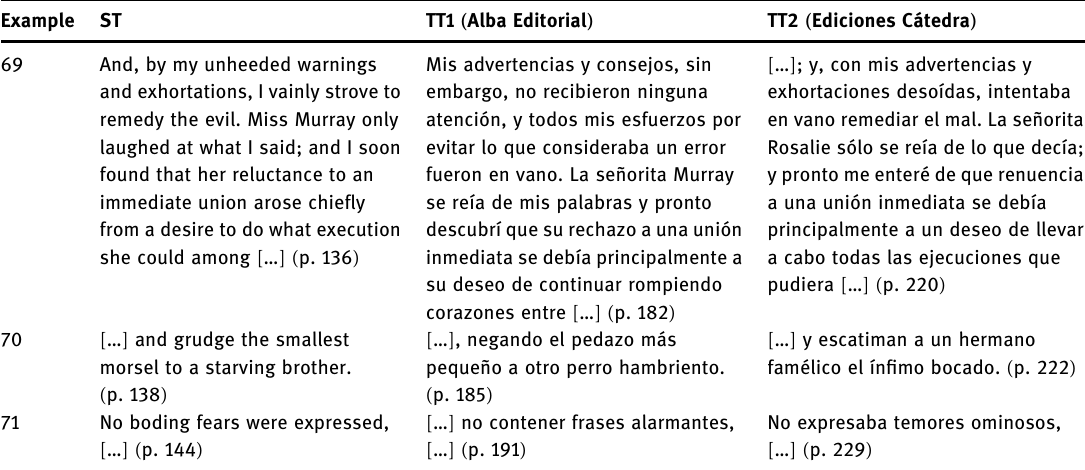
Table 14: Examples taken from Chapter 17 Example ST TT1 ( Alba Editorial )